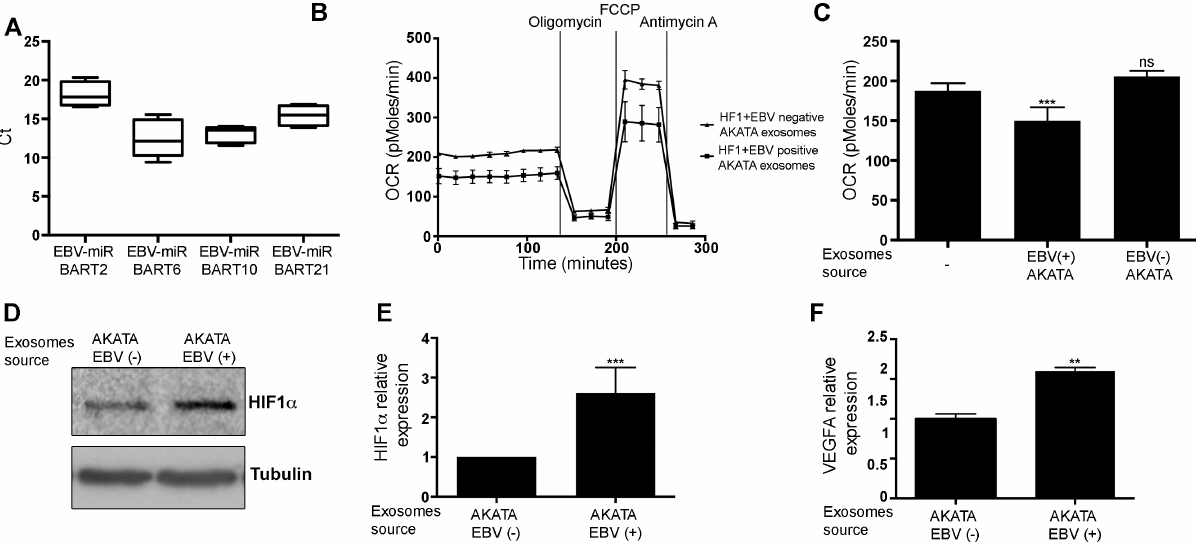
Fig 4. Exosomes secreted from EBV infected cells transfer the virus miRNAs and induce reverseWarburg effect. (A) Expression of 4 mature EBV miRNAs in exosomespurifiedfrom AKATA growth media. Detection of the mature EBV miRNAs was performed using the EBV-miR LNA PCR primer sets (Exiqon). (B-C) Oxygen consumption rate (OCR) as measuredusing the Seahorse XF24 Analyser. 10 5 humanfibroblasts cells were educatedusing 2.5x10 9 of the indicatedexosomes. Cells were seeded at a density of 4x10 4 cells per well and the assay was performed accordingto the manufacturer’s Mito stress protocol. Representative Mito stress assay of the mitochondrial structure is shown on the left panel(B). The bar graph presents the averagebasal oxygen consumption of 3 biologicalrepeats (C). (D-E) HIF1 α protein expression, in humanfibroblastscells educatedusing the indicatedexosomes, as measuredby immunoblot (D). The bar graph presents the averagerelativeexpressionin 3 independentexperiments (E). (F) Expression of the HIF1 α target geneVEGFA. mRNA levels were determined by quantitative real-time PCR (qRT-PCR). Tubulin beta (TUBB) levels were used for normalisation. In all panels, except to panel B, the graphspresent the mean and standarddeviationof 3 biological repeats. Statistical significancewas denotedby * P < .05, ** P < .01, *** P <